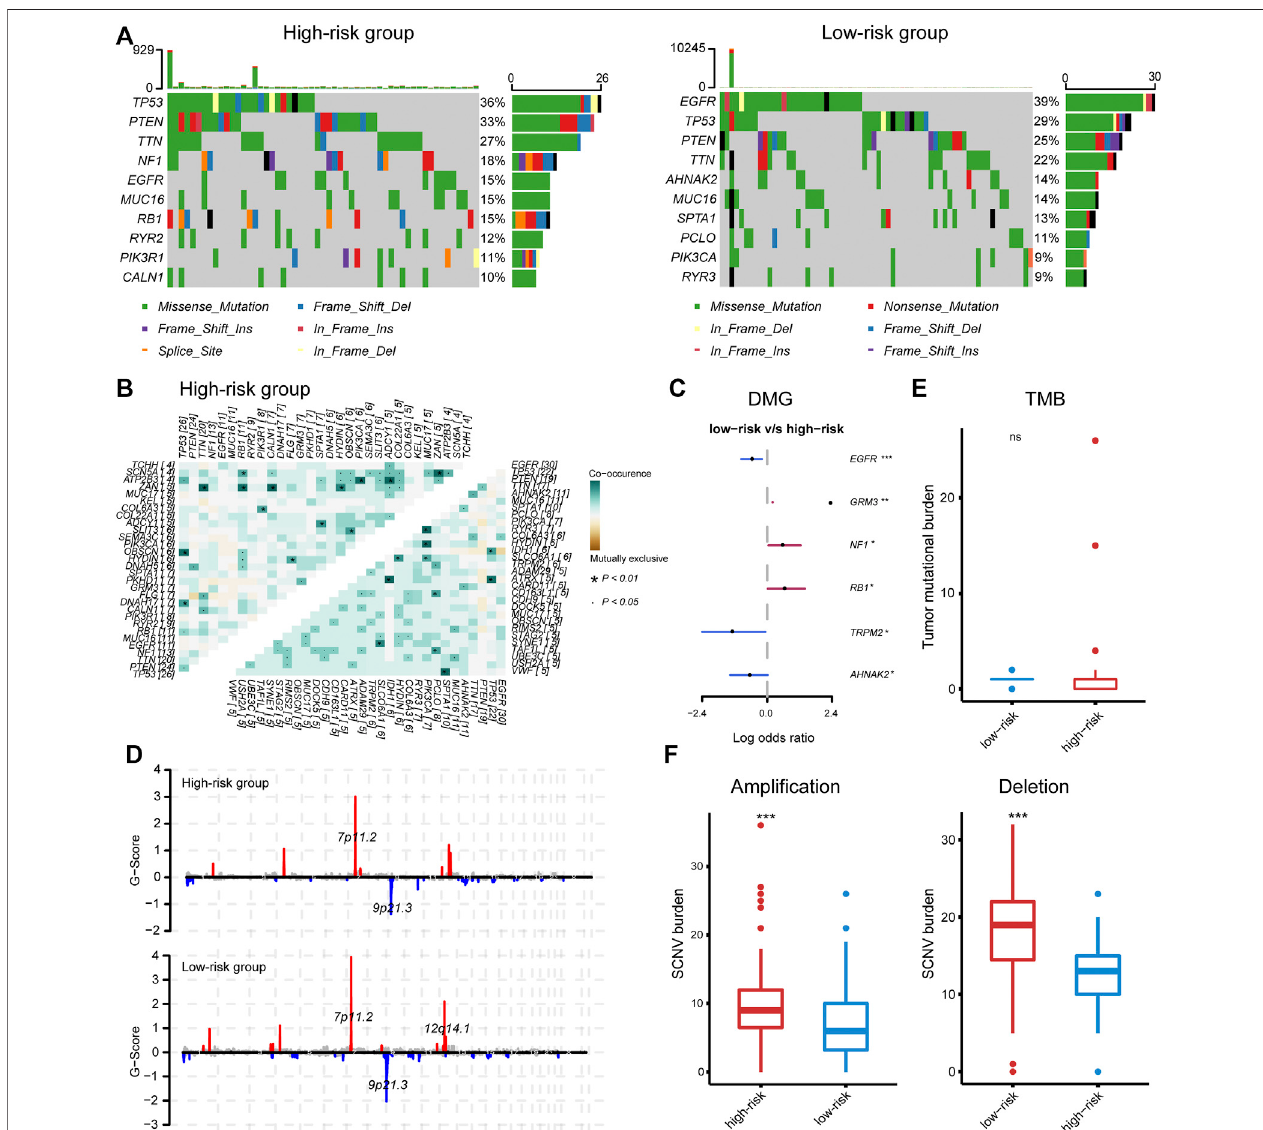
FIGURE 5 | (A) The top mutated gene in the high- and low-risk group, respectively. (B) Co-occurring and mutually exclusive gene pairs. (C) Signi fi cantly differentially mutated genes. (D) Signi fi cant ampli fi cations and deletions in tumor chromosome. (E, F) The tumor mutation burden and somatic number alteration load between the high- and low-risk